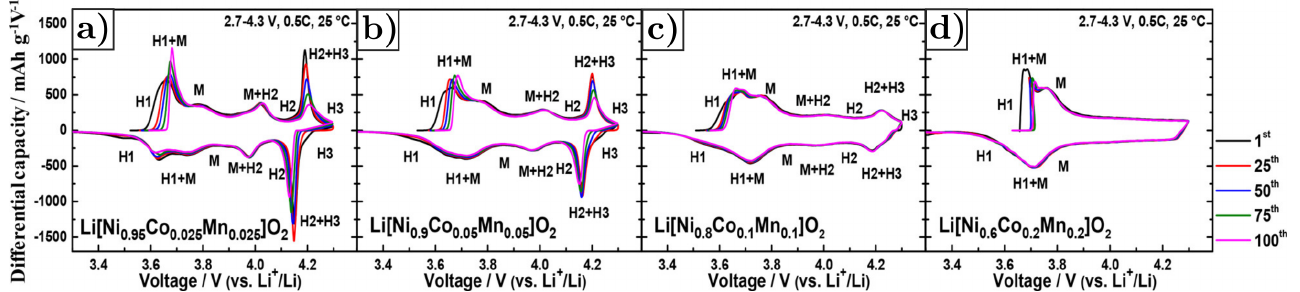
Figure 24. Differential capacity curves of Li[NixCoyMn 1–x–y ]O 2 with different Ni content: ( a ) x = 0.95, ( b ) x = 0.9, ( c ) x = 0.8, and ( d ) x = 0.6 as a function of the number of cycles. Reprinted with permission of [106], ©2018 American Chemical Society.